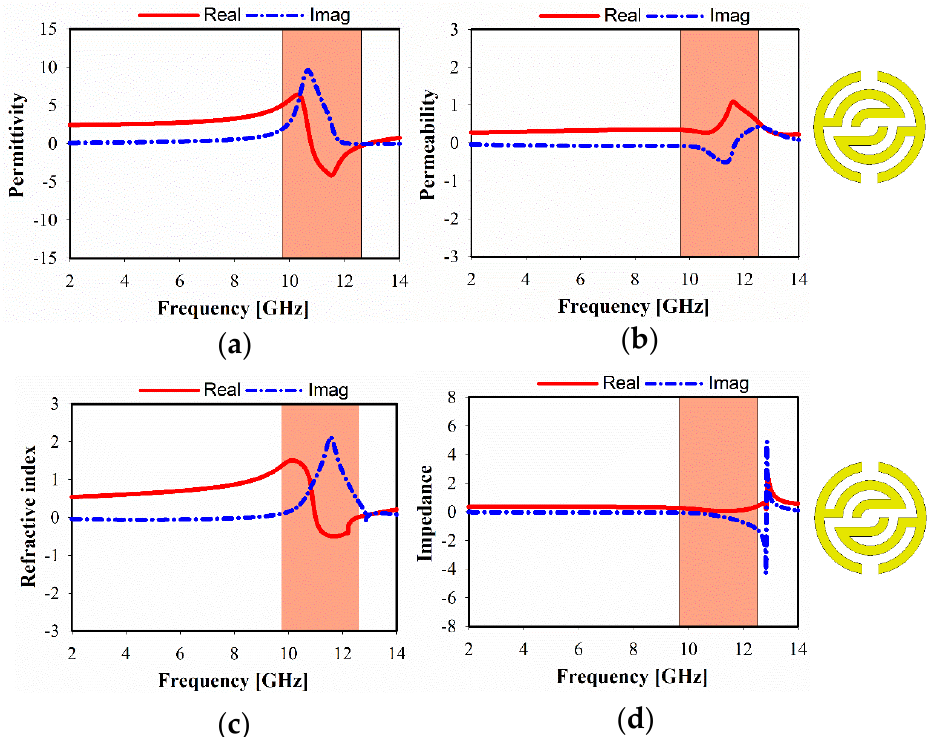
Figure6. Metamaterial, simulatedresultsof1 × 1unitcell: ( a )permittivity, ( b )permeability, ( c )refractive index, and ( d ) Figure 6. Metamaterial, simulated results of 1 × 1 unit cell: ( a ) permittivity, ( b ) permeability, ( c ) refractive index, and ( d ) impedance.